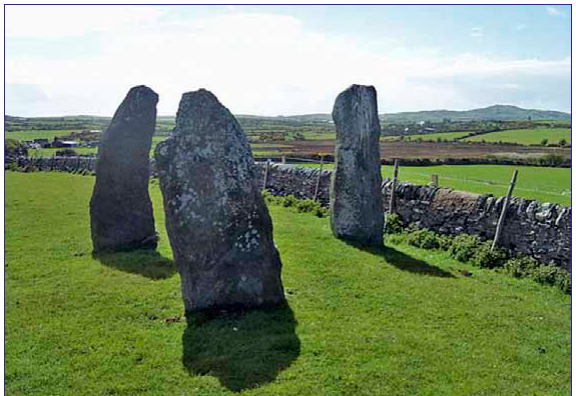
fig. 1. llanfechell near amlwch (anglesey). Three megalithic menhirs (llanfechell Triangle), neolithic Period, ca 3000 BC. Source : http://www.themodernantiquarian.com/site/127/mein_ hirion.html - posted by Iron Man.